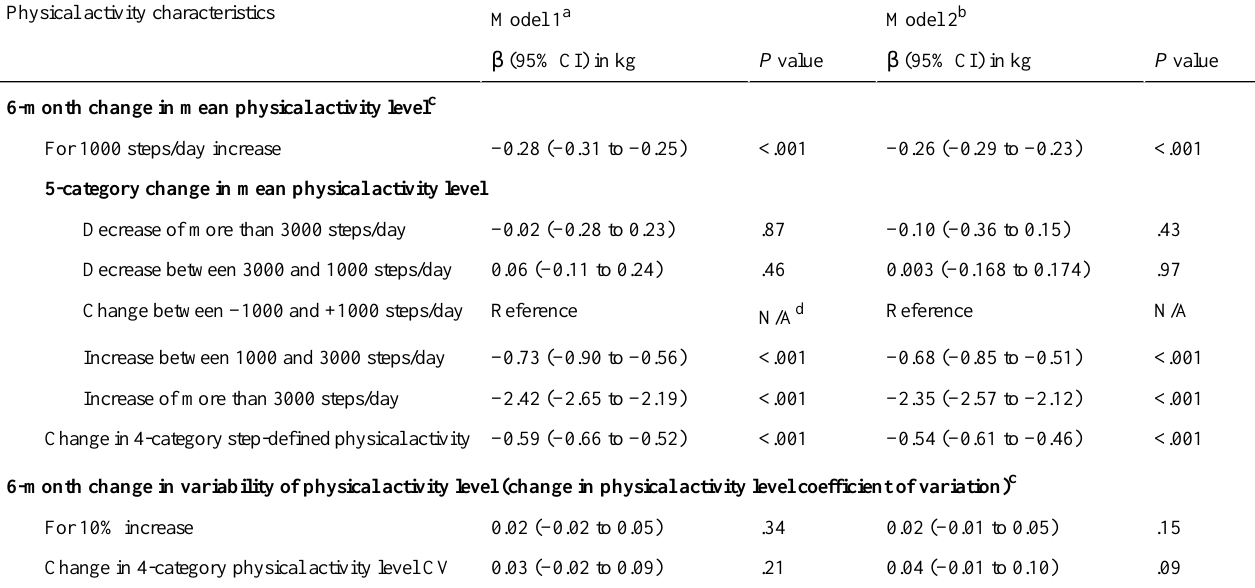
Table 3. Associations of 6-month change in physical activity level and variability with 6-month weight change